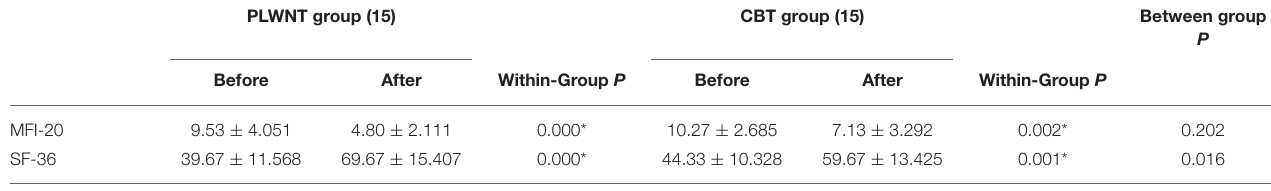
TABLE 4 | The results of 30 CFS patients with MFI-20 and SF-36. PLWNT group (15) Between group